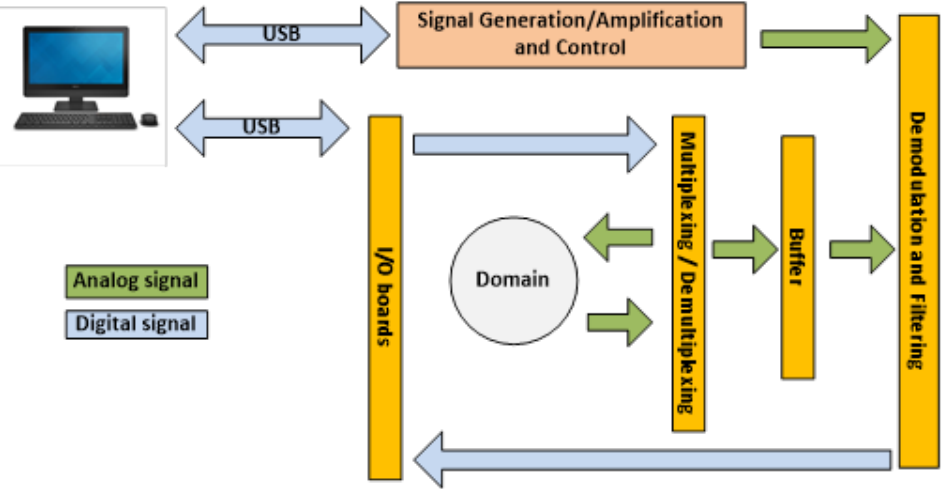
Figure 5. Block diagram of the actual tomographic system main modules.